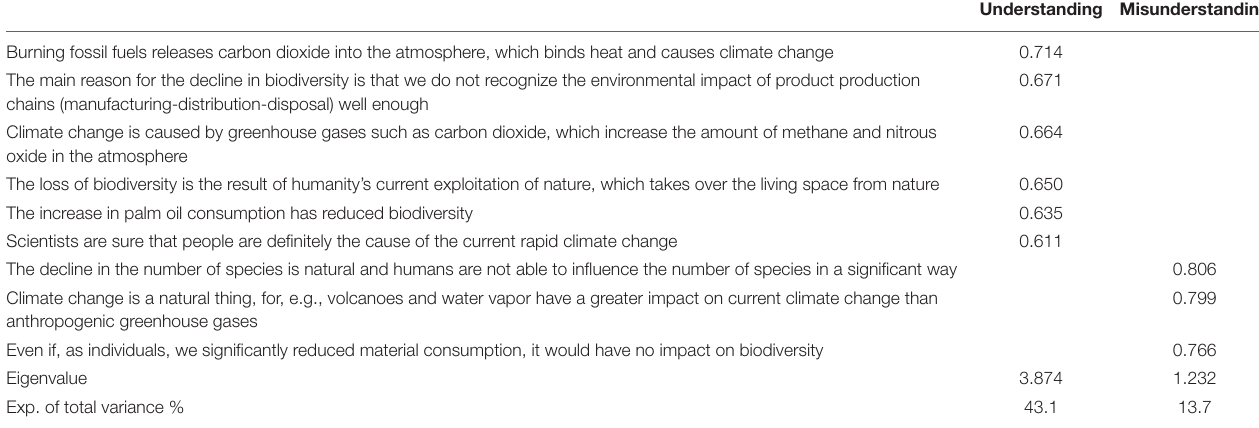
TABLE 3 | Finnish people’s awareness of environmental issues ( n = 2006).